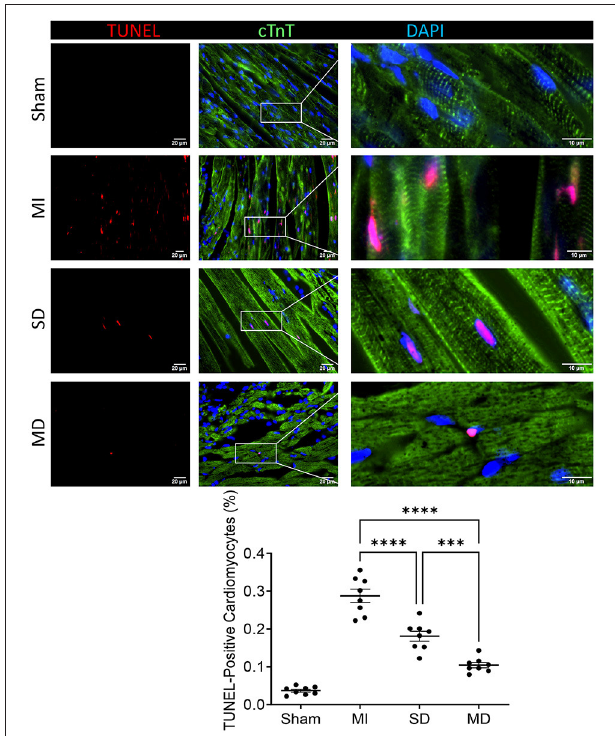
FIGURE 7 | Assessment of cell apoptosis. After 4 weeks of different treatments, sections from the MI margin were stained with TUNEL to reveal apoptotic cardiomyocytes (red) and normal cardiomyocytes expressing cardiac troponin T (cTnT; green). The proportion of TUNEL-positive cells in total cells was calculated and expressed as a percentage. Data are means ± SE. Eight animals per group. Scale bar = 20 and 10 µ m for the unenlarged and enlarged panels, respectively. One-way ANOVA with Dunn’s multiple comparisons test. *** p < 0.001; **** p <